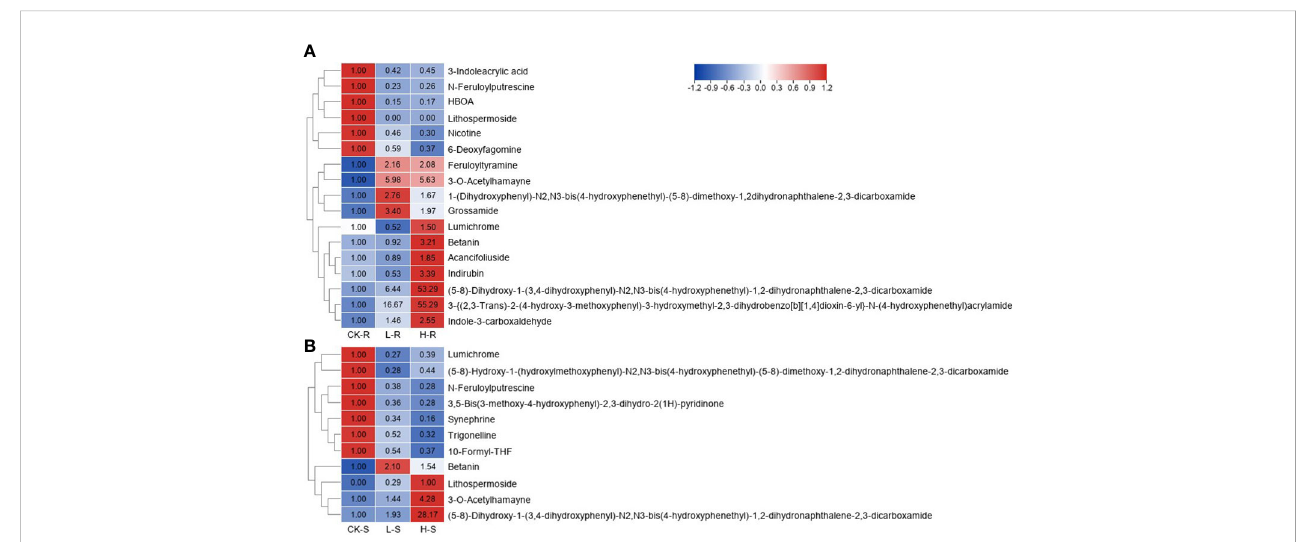
FIGURE 8 Heat map of different alkaloids among three different NaCl conditions. CK, 0 mM NaCl; L, 50 mM NaCl; H, 300 mM NaCl. (A) Heat map in the root (R) tissue. (B) Heat map in the shoot (S) tissue. Different metabolites were selected based on projection (VIP) >1 and fold change (FC) ≥ 2 or ≤ 0.5 in any of the comparison groups in S and R. The FC values are displayed in the heat map which uses the data of CK-R or CK-S as the calibrator, except for lithospermoside (no detection in the CK-S, and thus H-S is used as the